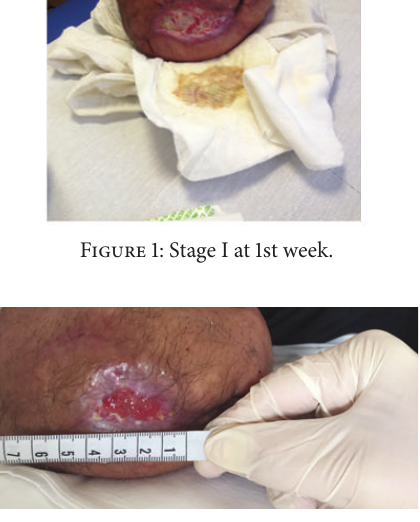
Figure 2: Stage II at 2nd week.